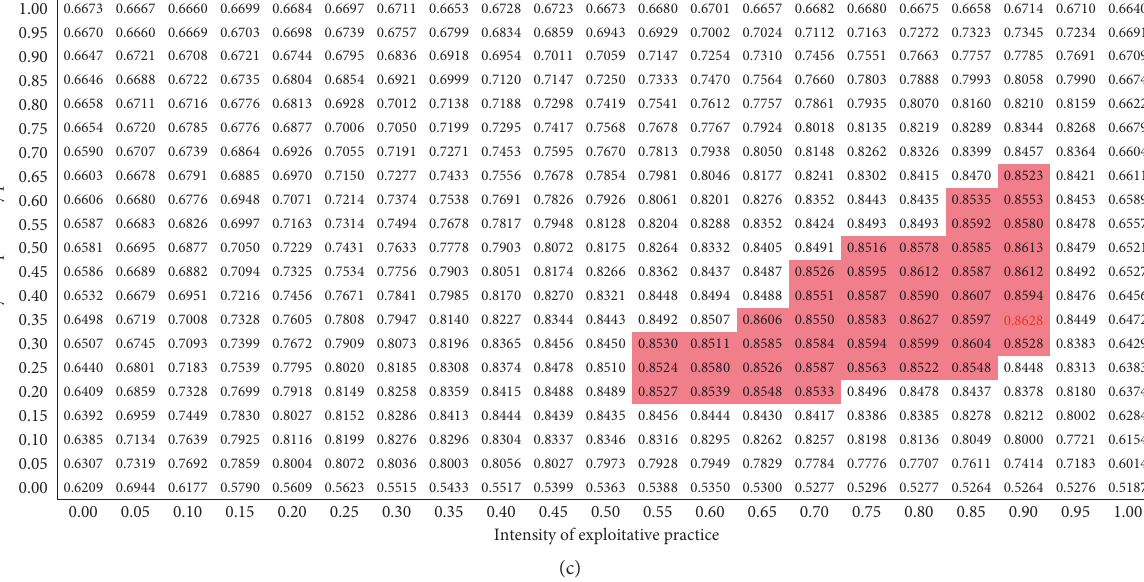
� 0.1. (b) p � 0.5. (c) p � 2 2 2